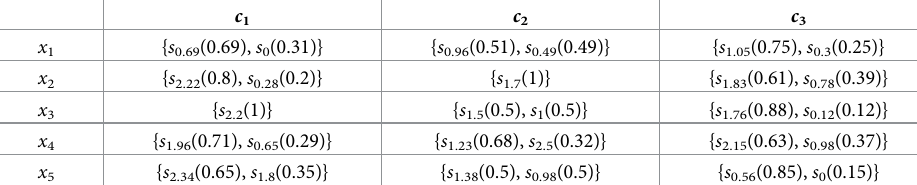
Table 6. The collective decision